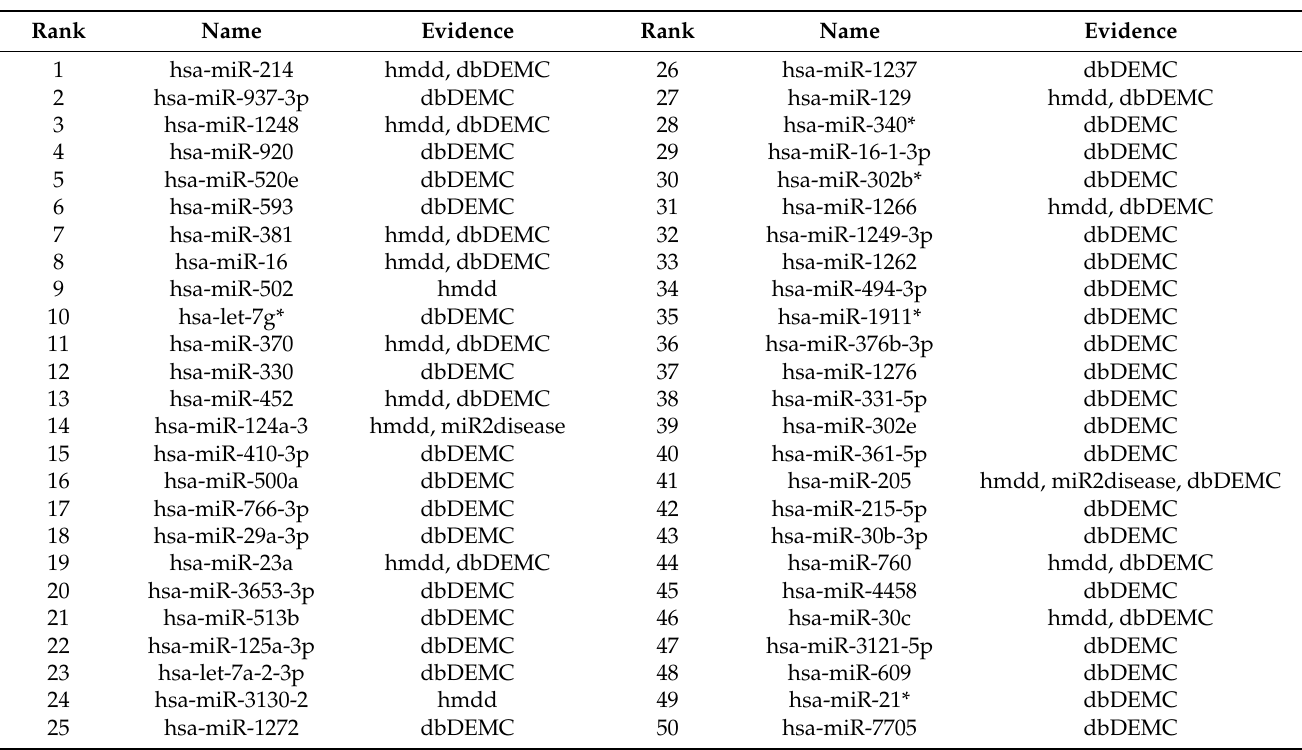
Table 5. Top 50 breast cancer-related miRNAs predicted by MDMF and their evidence. All miRNA candidates were proved to be related with breast